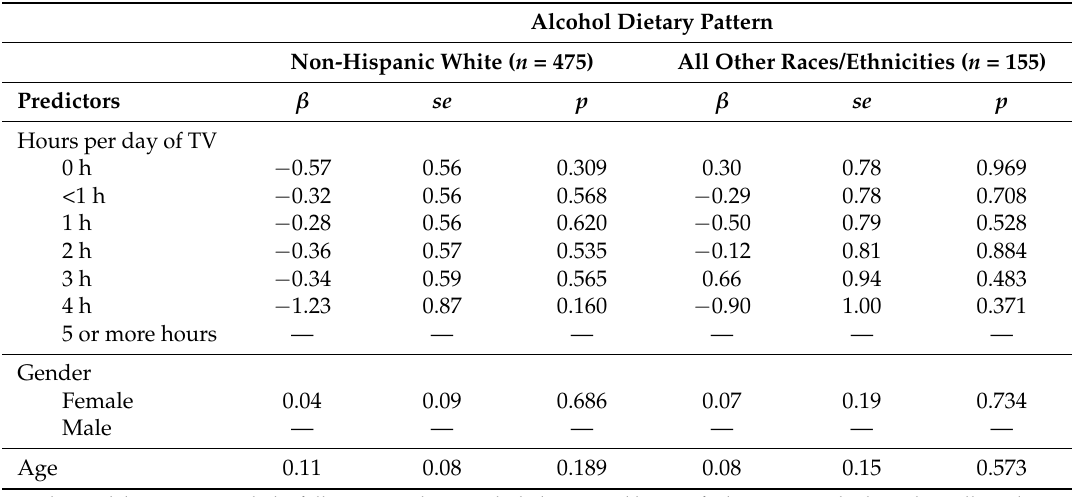
Table 3. Associations between behavioral factors and alcohol dietary pattern scores by race/ethnicity. Alcohol Dietary Pattern Non-Hispanic White ( n = 475) All Other Races/Ethnicities ( n = 155)